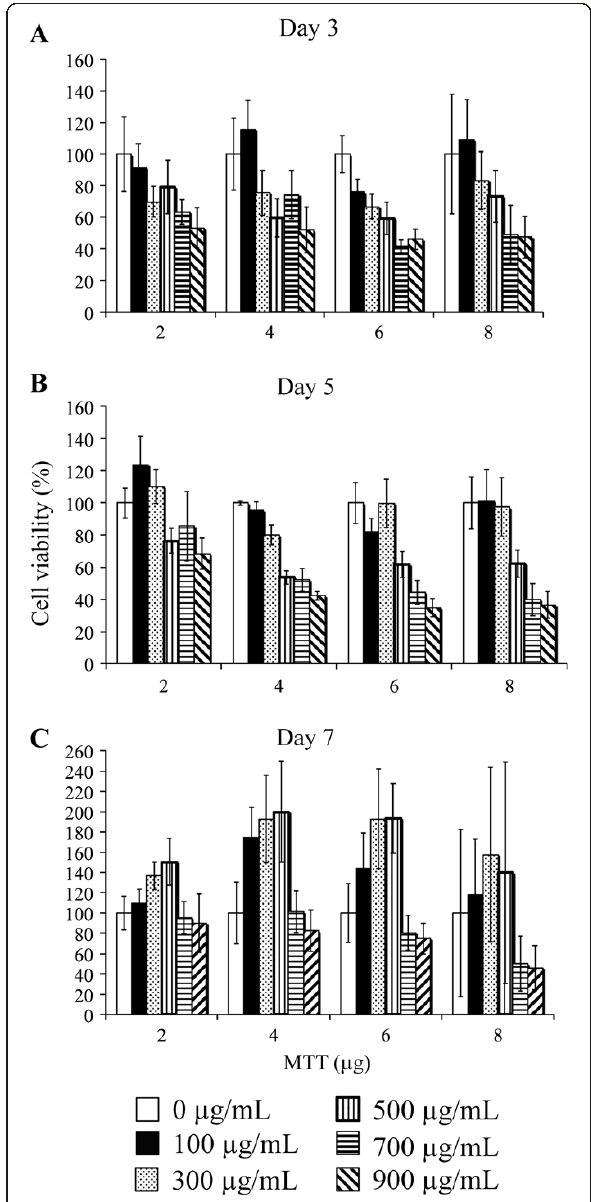
Figure 1 Optimisation experiment of MTT assay on COS-7 cells. Cells were treated with various concentrations of C. longa hot water extract as indicated in quadruplicate. After 3 days ( A ); 5 days ( B ); and 7 days ( C ) of incubation, cells were subjected to viability analysis using MTT assay with different amounts of MTT (2-8 μ g). Bar graph represents a mean value whereas an error bar indicates the uncertainty value of three independent